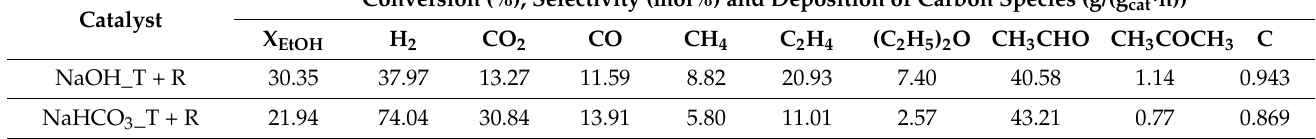
Table 1. Activations of the NaOH_T + R and NaHCO 3 _T + R catalysts in the ESR reactions for 5 h: the averages of the ethanol conversion, selectivity of the production, and deposition weight of carbon